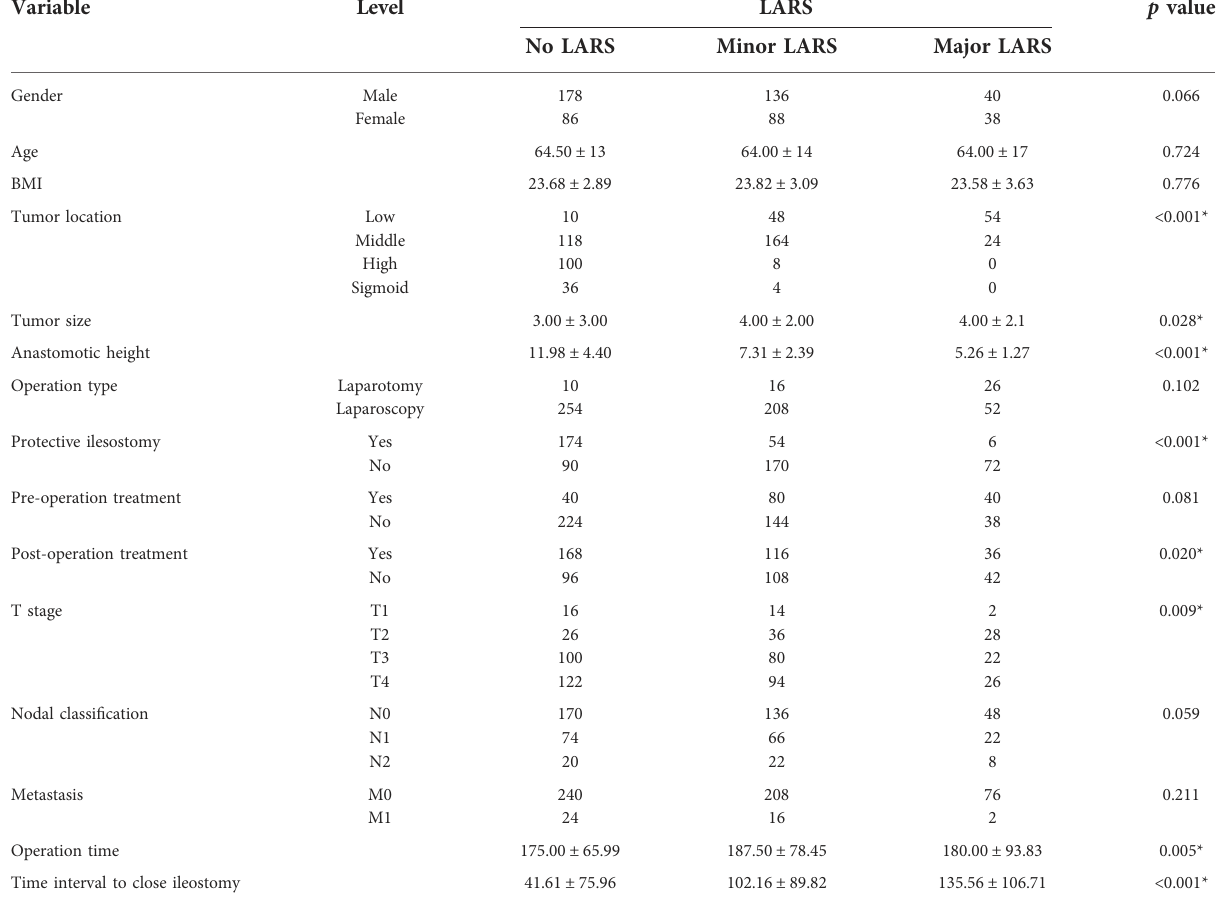
TABLE 2 Distribution of patients according to LARS score and study variables ( n =566).